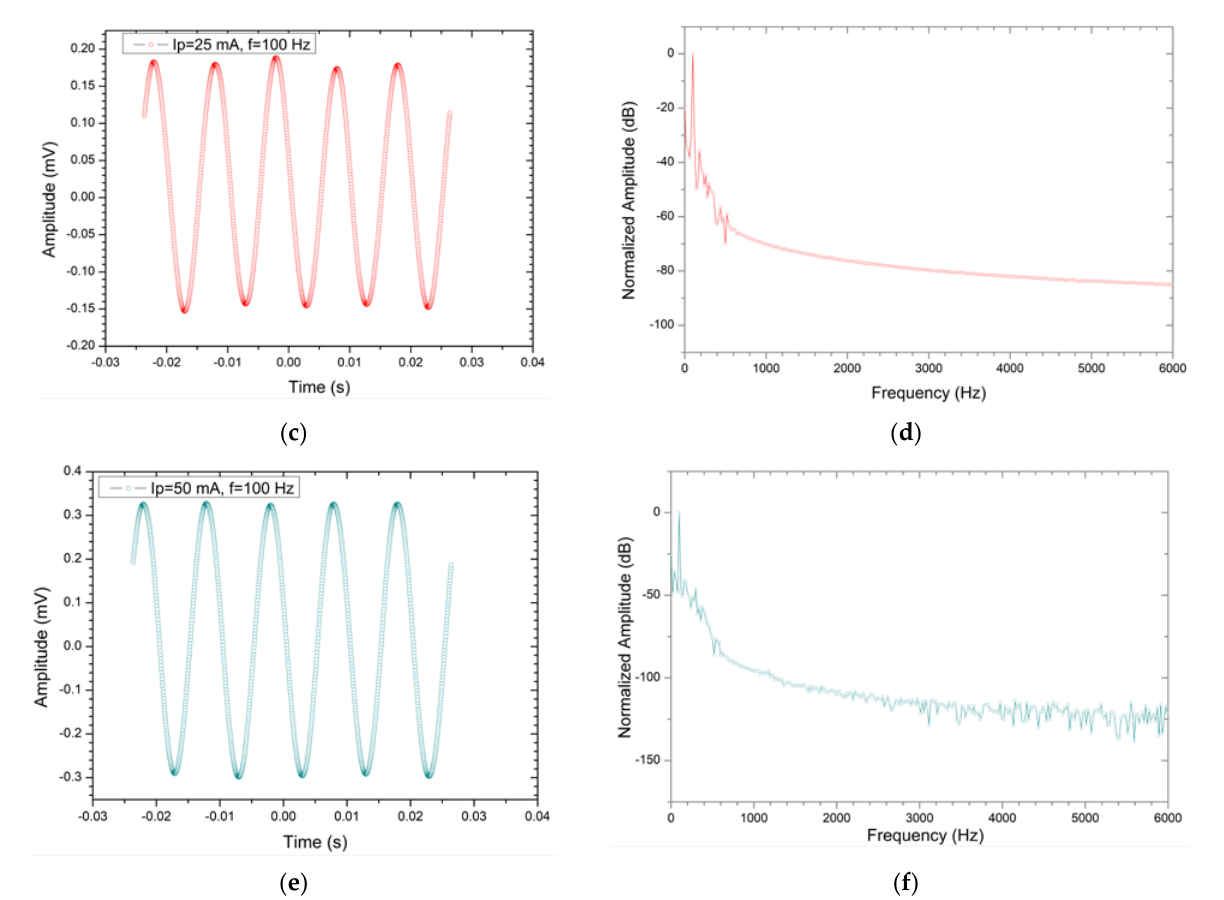
Figure 24. Demonstrator chip: Time-domain characteristics ( a , c , e ) and Fourier transforms ( b , d , f ) for the output voltage when a 5 mA, 100 Hz, sinusoidal waveform current is injected into the U-shaped trace, f = 100 Hz, with the amplitude of: ( a , b ) 5 mA; ( c , d ) 25 mA; ( e , f ) 50 mA.